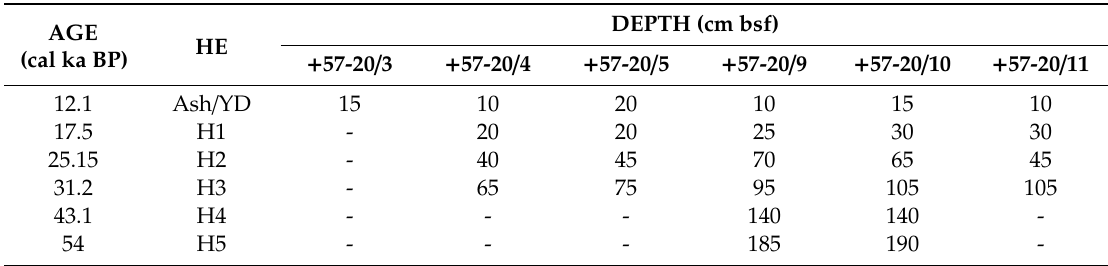
Table 3. Age-model proposed in this work based on the six cores studied. Calibrated age based on studies by other authors